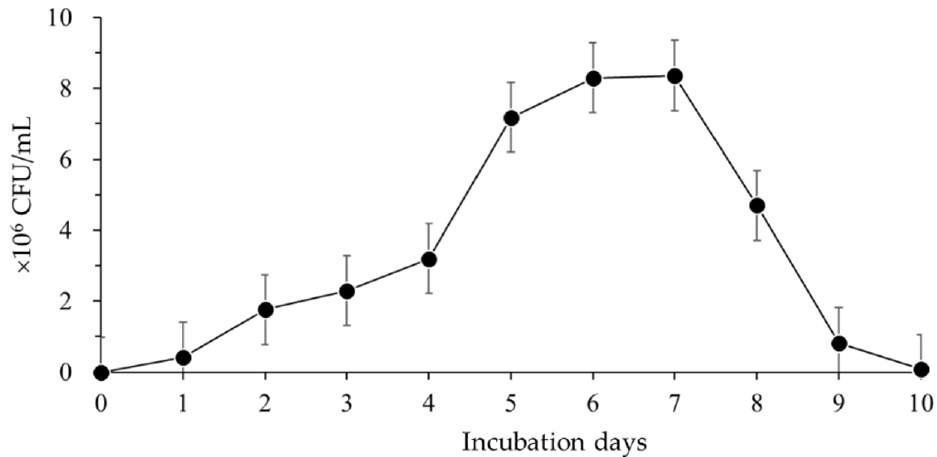
Figure 1. Colony-forming units (CFUs) of Bacillus velezensis CE 100 during the incubation period. Error bars represent standard deviation ( n = 3).